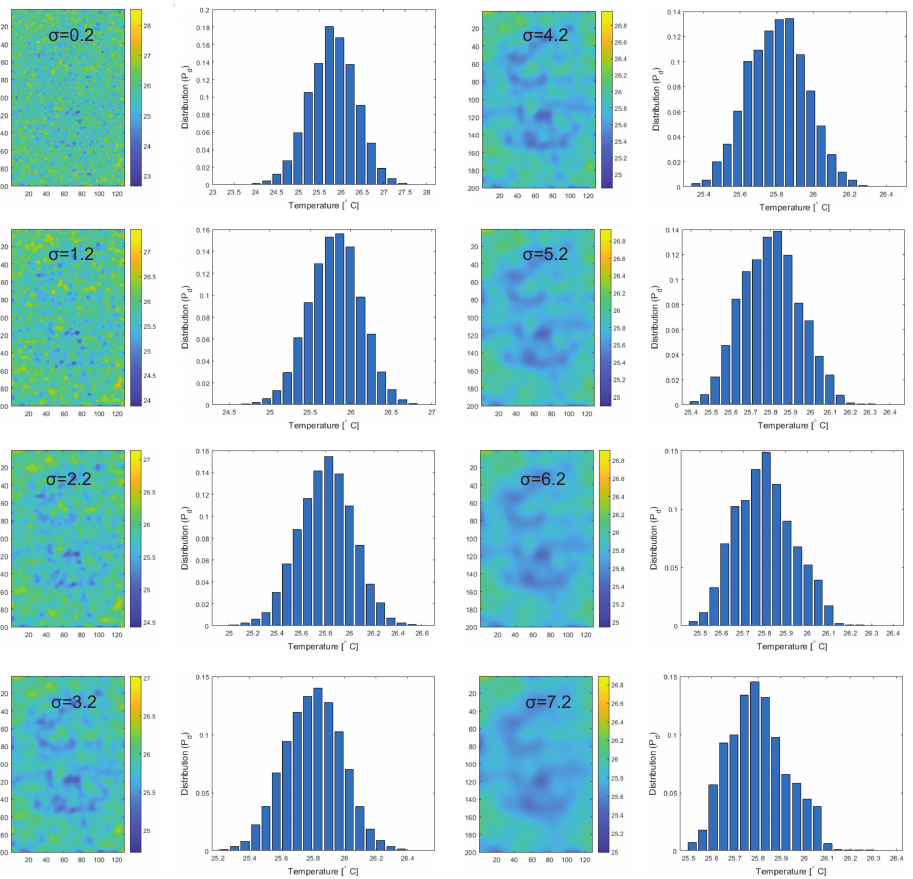
Figure 19. Spatial effects of 2D Gaussian filter with σ .